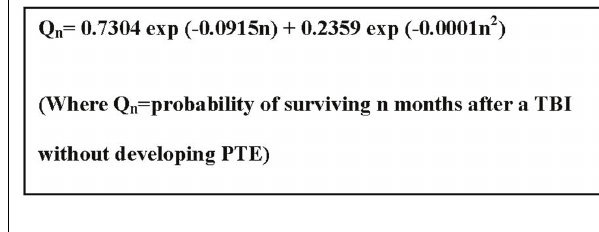
the presence of hematoma or retained metal fragments (Weiss et al., 1986). Only five affected brain areas significantly predicted seizure occurrence: right vertex gray matter, left convexity cortex, left temporal gray matter, right frontal white matter, and right corona radiate. Lesions in the left hippocampus correlated with increased seizure frequency, whereas insula and splenium lesions correlated with lower seizure frequency. Lesions of the